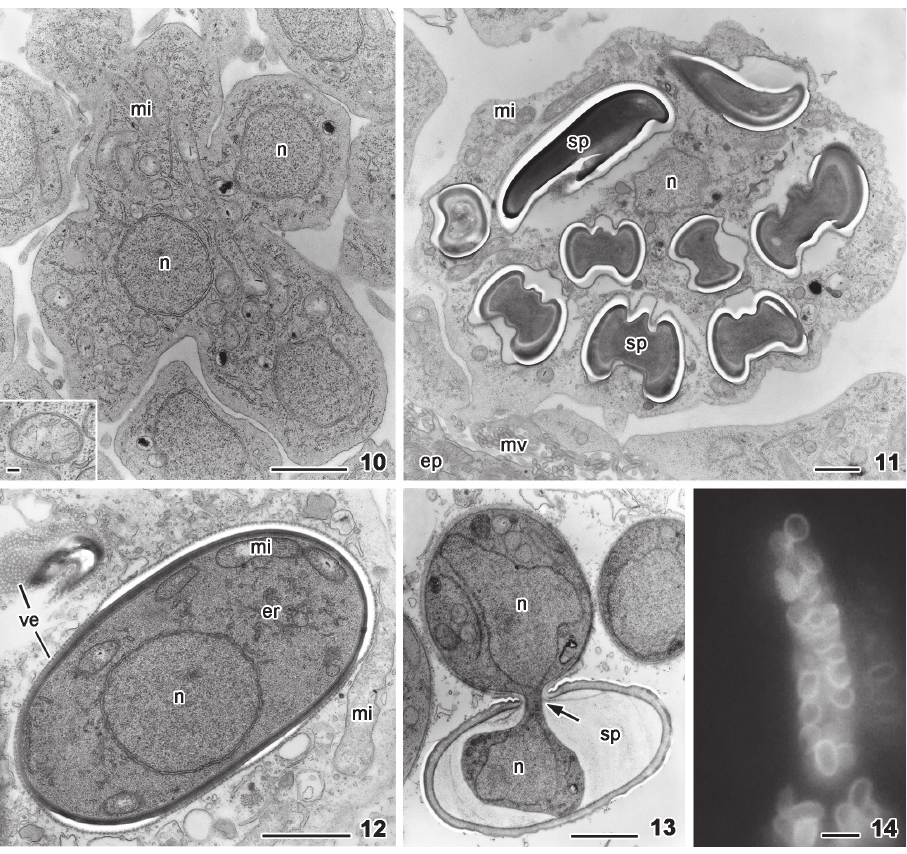
Figures 10–14. Nephridiophaga blattellae , 10–13 transmission electron microscopy, 14 Calcofluor white staining. 10 Meront with several nuclei (n) and mitochondria (mi) in the lumen of Malpighian tubule. Inset: Mitochondrium with tubular to sac-like cristae. 11 Sporogenic plasmodium containing mature spores (sp), mitochondria (mi), and vegetative nuclei (n) in the cytoplasm. The plasmodium is anchored to the microvilli (mv) of epithelial cells (ep) of the tubule. 12 Young spore within the cytoplasm of a sporogenic plasmodium, surrounded by a layer of vesicles. The spore cytoplasm contains one nucleus (n), mitochondria (mi), and endoplasmic reticulum (er). 13 An infectious sporoplasm hatches through the central spore opening, leaving behind the spore wall of the emptying spore (sp). The nucleus (n) is squeezed through the tiny spore opening. 14 Calcofluor white stains the spore wall indicating the pres- ence of chitin (bluish color). Scale bars: 1 µm ( 10–13 ), inset 0.1 µm ( 10 ), 5 µm ( 14